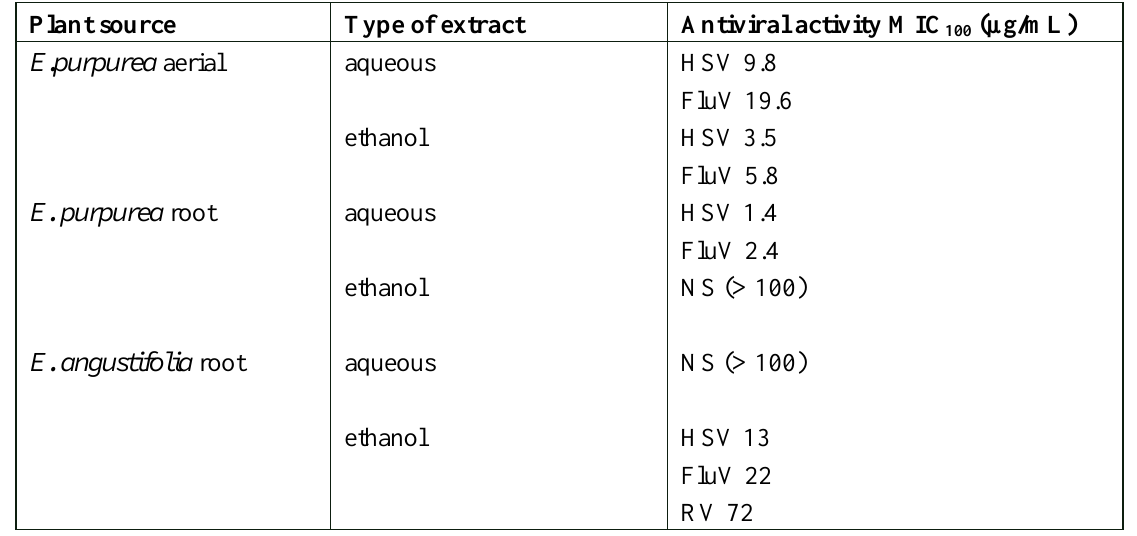
Table 4. Antiviral MICs (minimum inhibitory concentration,